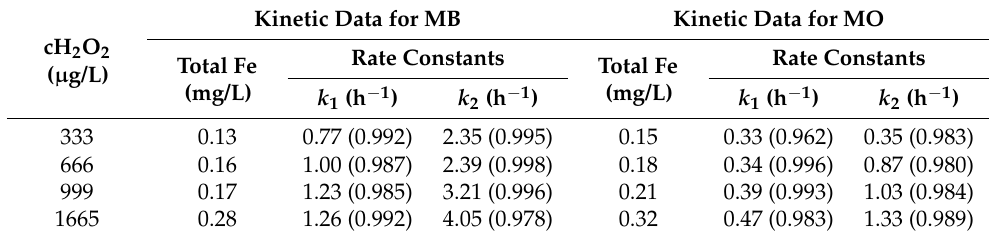
Table 2. Rate constants of the photo-Fenton process as a function of S 2 O 82 − concentration. Kinetic Data for MB Kinetic Data for cS 2 O 82